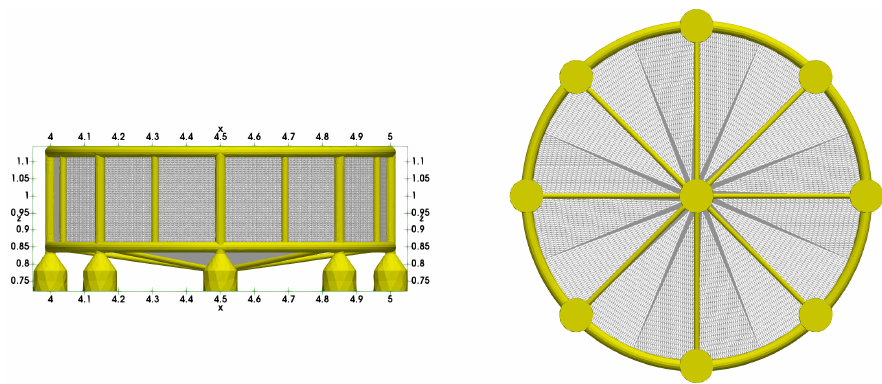
Figure 5. Side and top view of the semi-submersible OOA structure (yellow) with nets